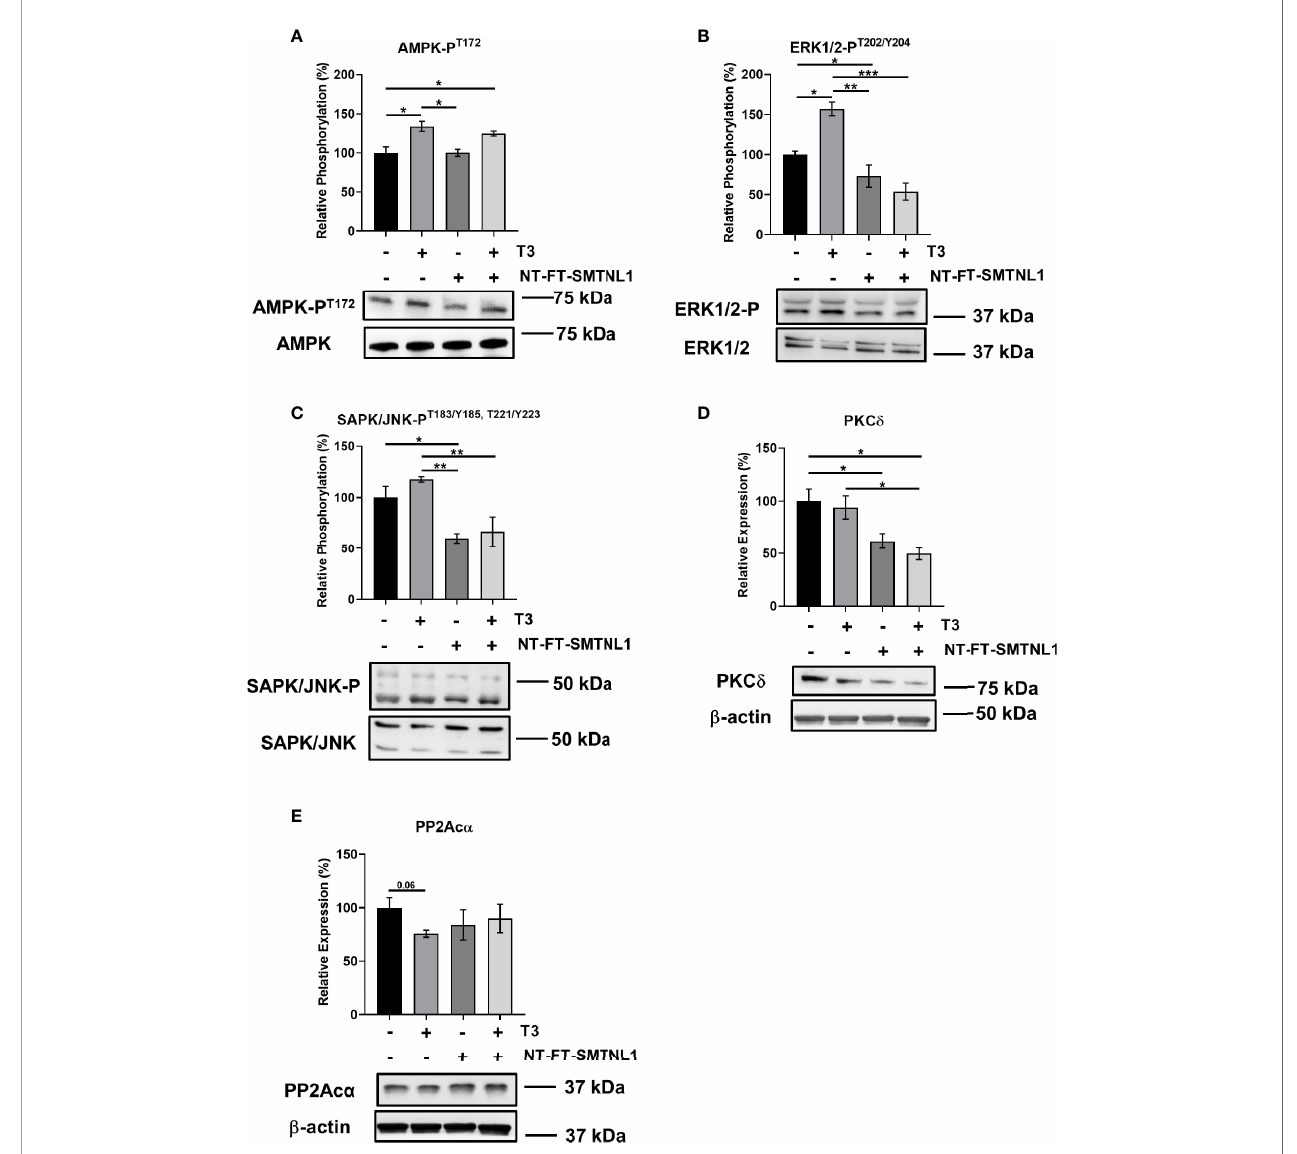
FIGURE 7 | T3 excess and SMTNL1 overexpression regulate the phosphorylation and expression of various Ser/Thr kinases and phosphatases. (A – E) Myoblasts were transfected with either empty vector or NT-FT-SMTNL1 and were differentiated in parallel with a 72-hour T3 treatment from Day 4 onwards. Whole-cell lysates were separated by SDS-PAGE followed by Western blot analysis using anti-AMPK-P T172 (A) , anti- ERK1/2-P T202/Y204 (B) , anti-SAPK/JNK-P T183/Y185,T221/Y223 (C) , anti-PKC d (D), and anti-PP2Ac a (E) antibodies. Values represent n=4-6, mean +/- SEM. Data were normalized to the empty vector-transfected control. Groups were compared using One-way ANOVA and Tukey ’ s post hoc test, p < 0.05 (*), p < 0.01 (**), p < 0.001